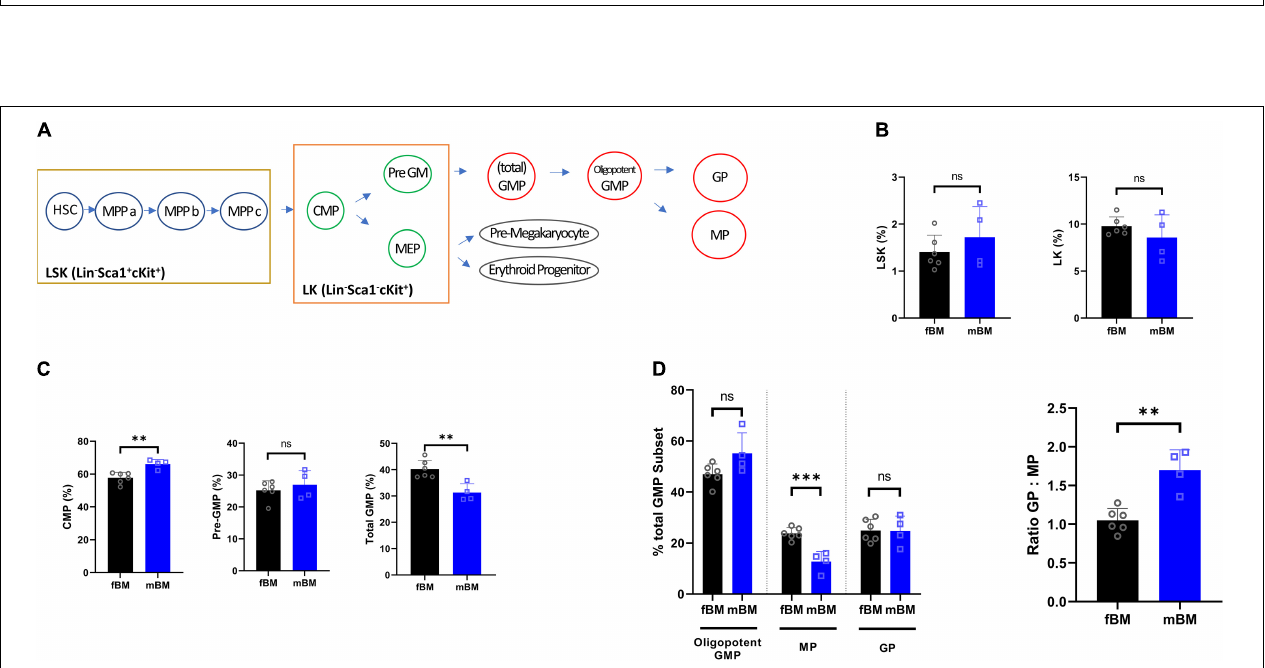
FIGURE 1 | Myeloid population of mBM exhibits consistent deficits compared to fBM. (A) Gating strategy (Top) and calculated frequencies (Bottom) of immune cell population from fBM and mBM by flow cytometry. (B) T cell proliferation assay of MDSCs isolated from fBM and mBM. The graph of the statistical analyses is presented. Unpaired t test; data are presented as mean ± SEM of value from four independent experiments from fBM and mBM, ∗ P < 0.05, ∗∗∗ P < 0.001.